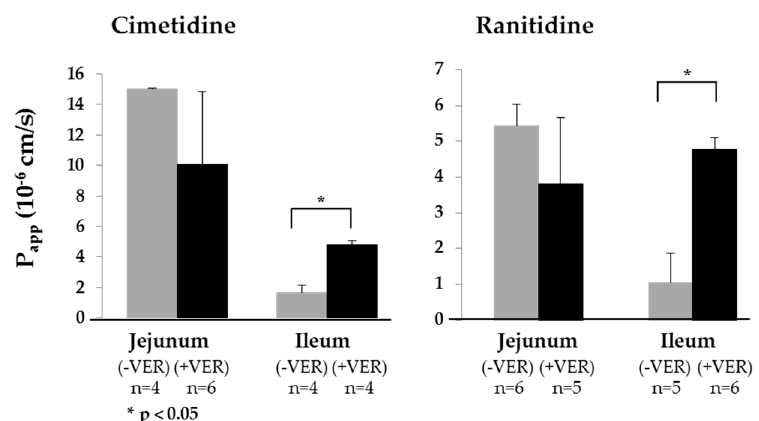
Figure 3. The activity of the P-gp efflux transporter was confirmed by measuring P app,pig of the P-gp substrates, cimetidine and ranitidine (both prepared at a concentration of 100 µ M in KBR), in the jejunum and the ileum in the presence (+VER; 100 µ M) or absence ( − VER) of verapamil (a P-gp inhibitor). Statistically significant differences (Student’s t-test) were observed for the ileum, which was consistent with the reports for humans in vivo. (Mean ± SD; n = number of replicates).